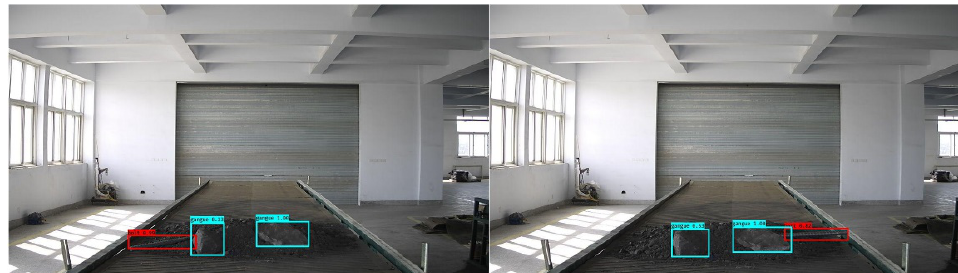
Figure 27. Semi-buried bolt and gangue detection.